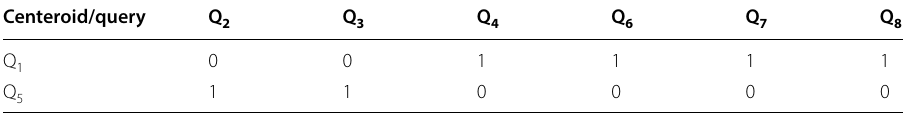
Table 7 Member’s affiliation (first loop Centeroid/query